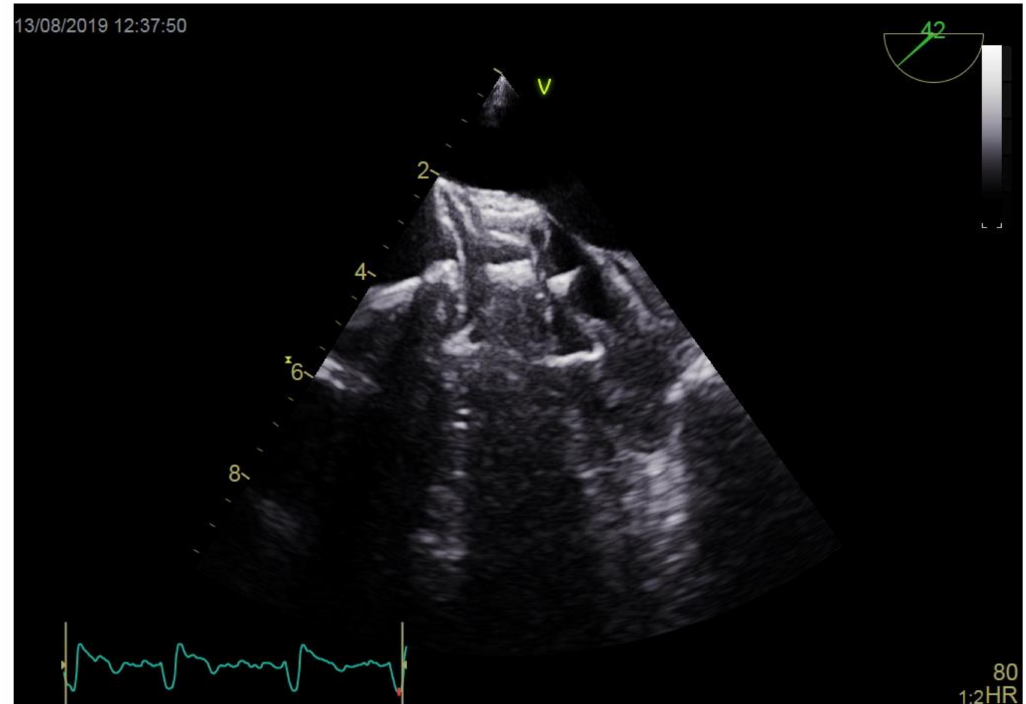
Figure 2. Occluder in contact with left atrial appendage